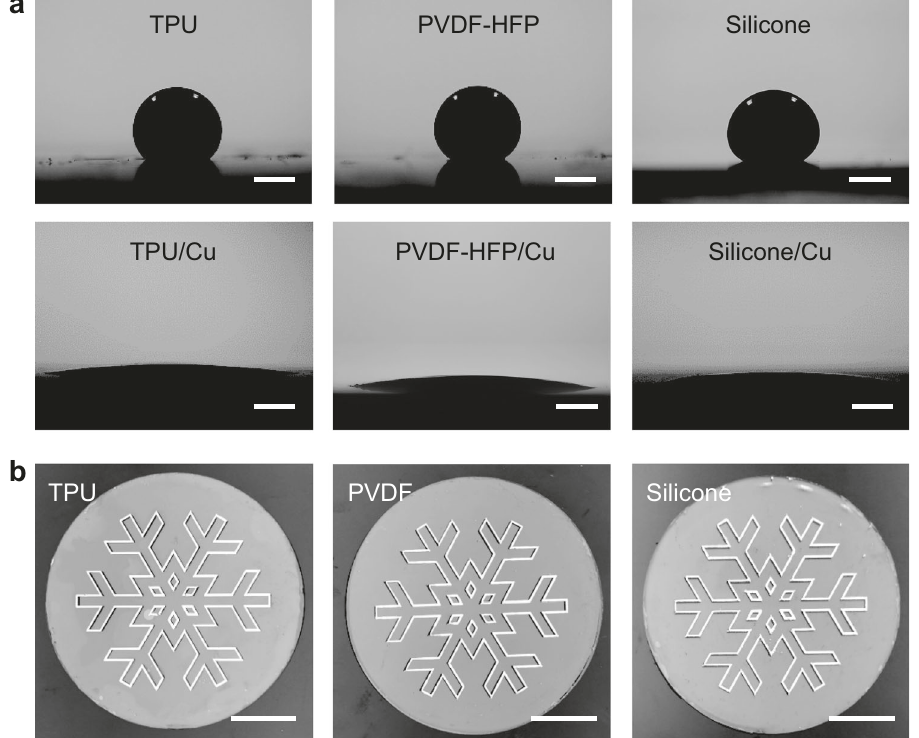
Fig. 4 Liquid metal patterning on various stretchable substrates. a Contact angle images of non-oxidized liquid metal droplets on different substrates at the pristine state (top) and after electroless deposition of Cu fi lms (bottom). Scale bar: 1 mm. b Optical images of snow fl ake- shaped liquid metal patterns prepared on different substrates. Scale bar: 2